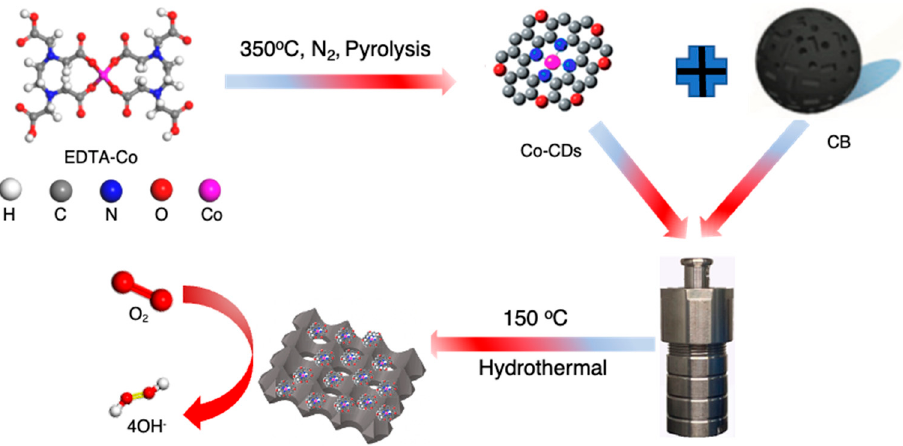
Scheme 1. Schematic illustration of the synthetic processes of